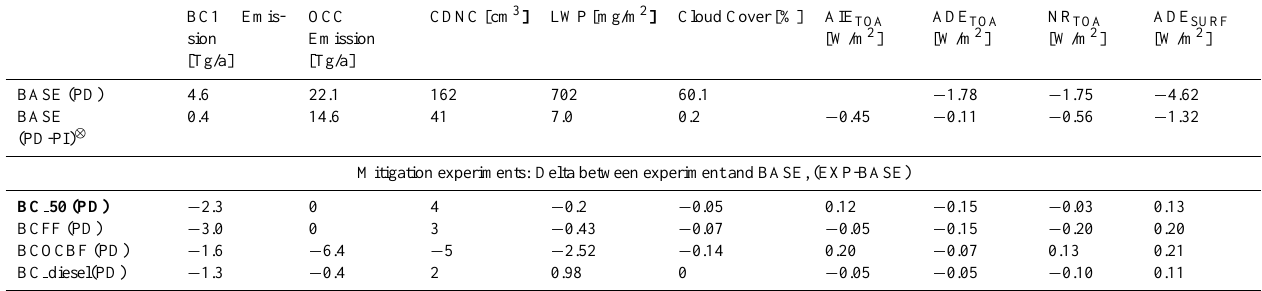
Table 5. Global mean budgets of the BASE experiment, for present day conditions (PD), differences between PD and PI, and differences between BASE run and BC reduction experiments under PD conditions. The following variables are listed: Non-biomass burning BC and OC emissions, ( ⊗ Biomass burning emissions are 3Tg/a BC and 24.8Tg/a OC for present-day and 1. T/g BC and 9.1Tg/a OC for pre-industrial times), CDNC (cm 3 ) , Liquid water path [mg/m 2 ], total cloud cover [%], the indirect and semi-direct effect (AIE), aerosol direct effect (ADE) at the surface and TOA, and total net radiative change (NR) [W/m 2